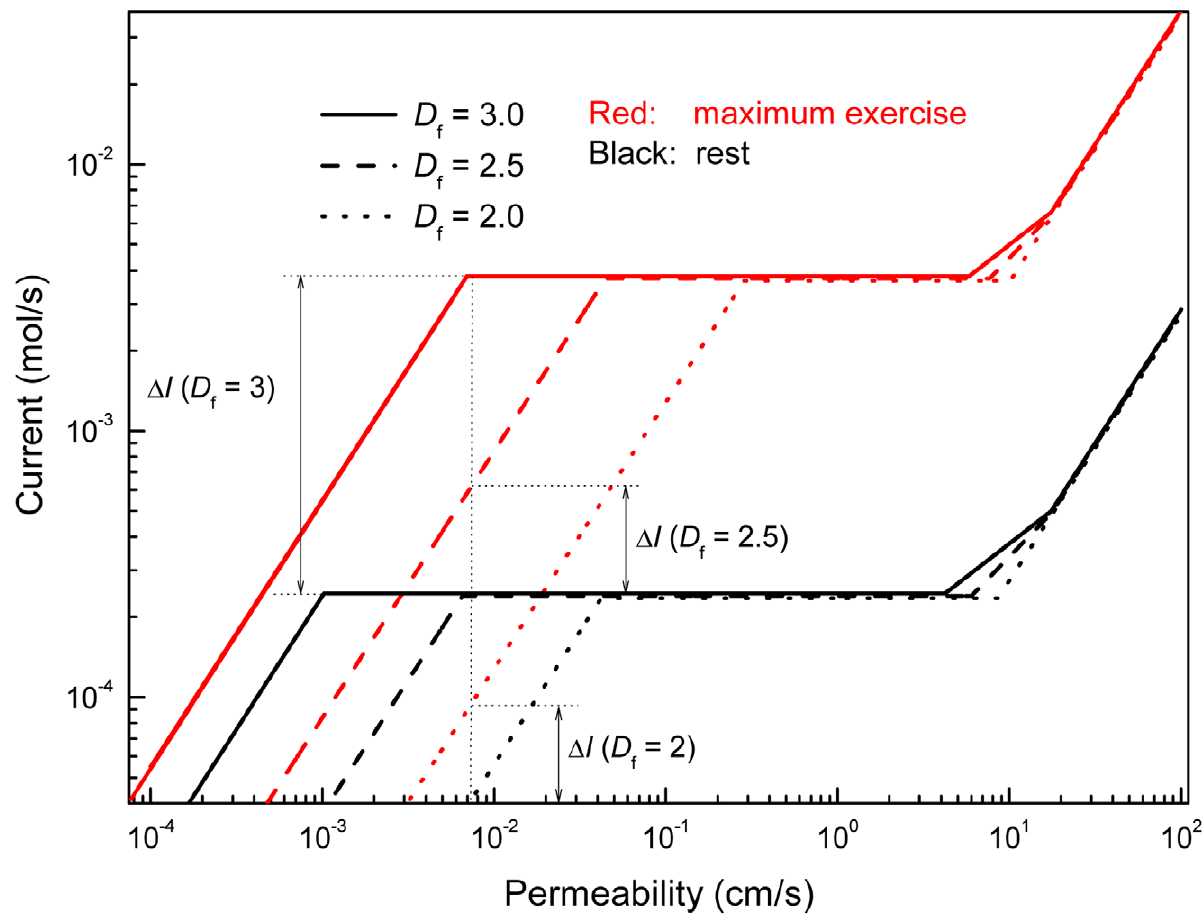
Figure 5. Computed oxygen currents for alternative architectures. Currents as a function of W are computed from Eqs. 4 and 5 for different fractal dimensions, D f , at fixed ‘ and side length of the gas exchanger (side length of 1/64 acinus, column 5 of Table 2). Other transport parameters in the equations are from Table 1.